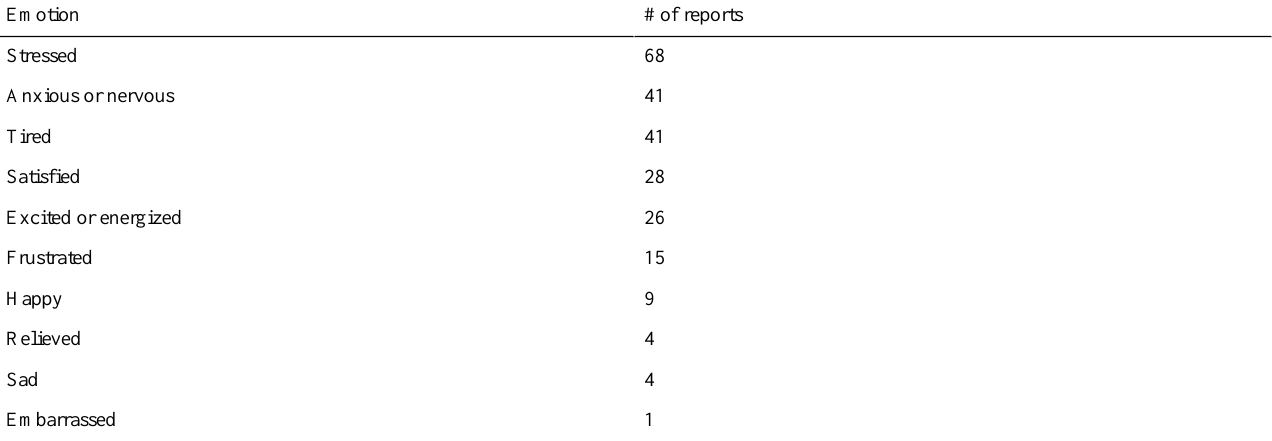
Table 3. Rank ordered emotions for sensorband